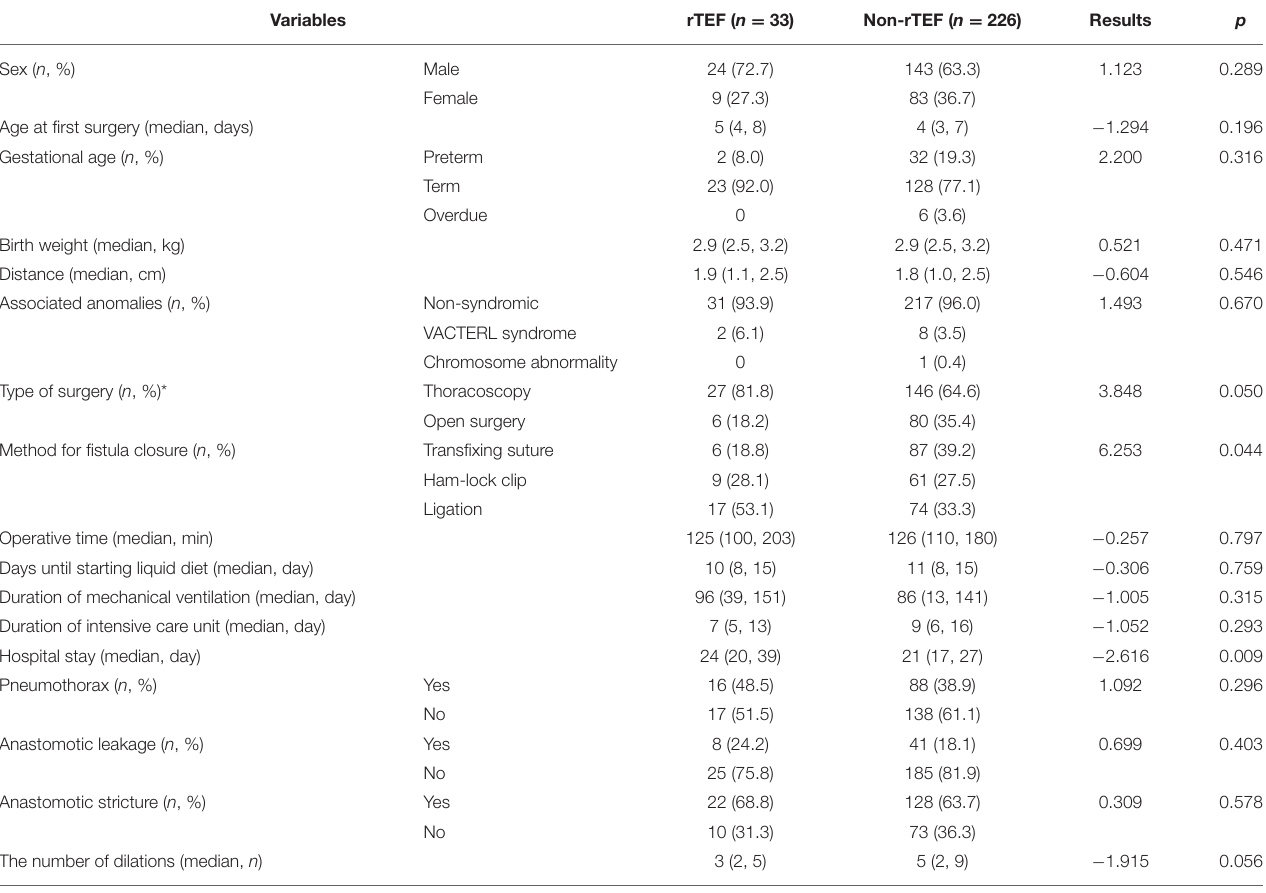
TABLE 1 | Comparison between rTEF and non-rTEF groups.